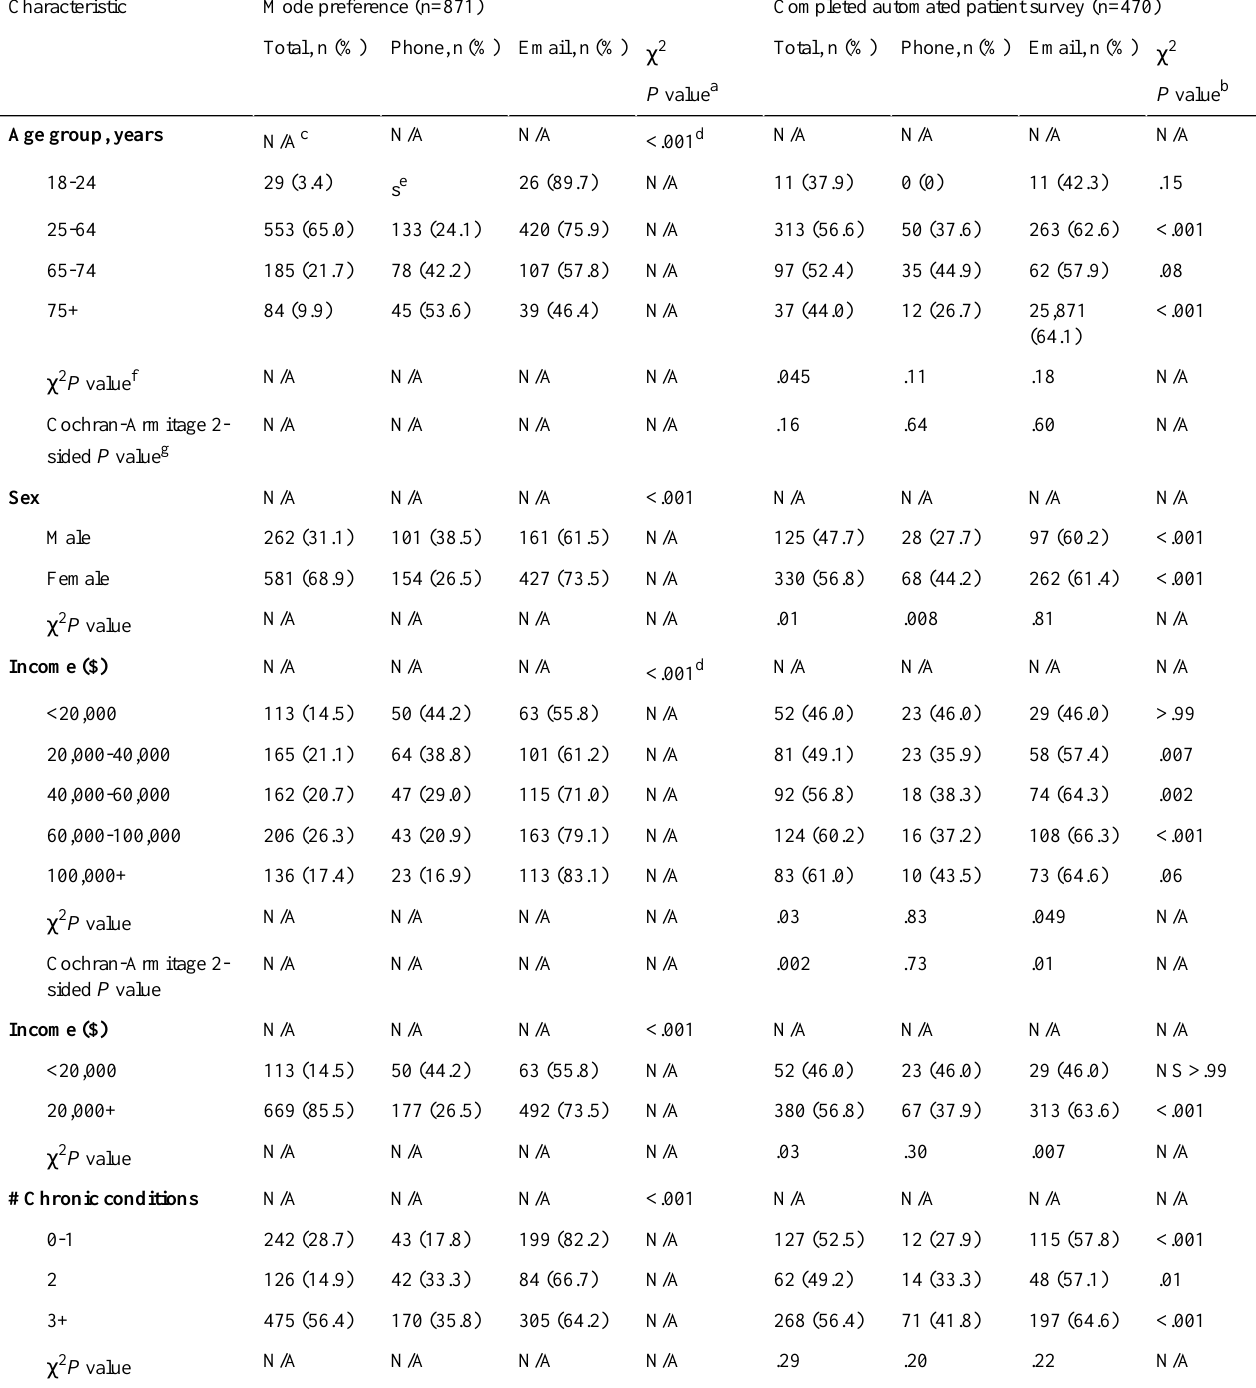
Completed automated patient survey (n=470)Mode preference